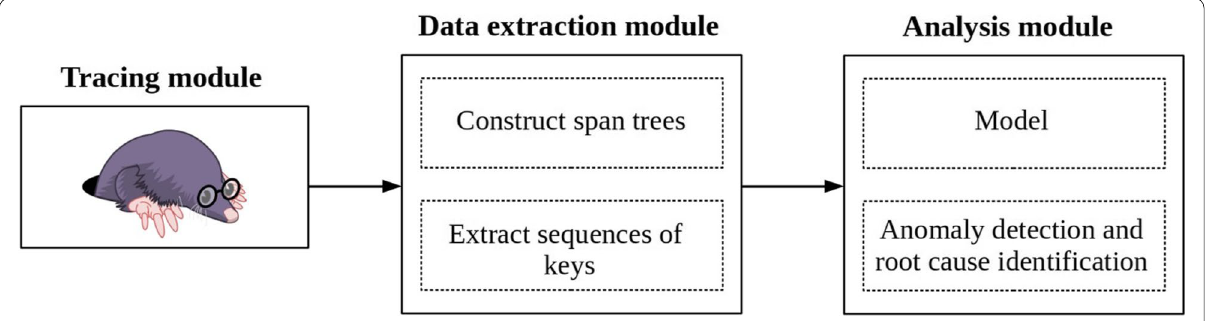
Fig. 1 The architecture of our proposed anomaly detection method for microservice